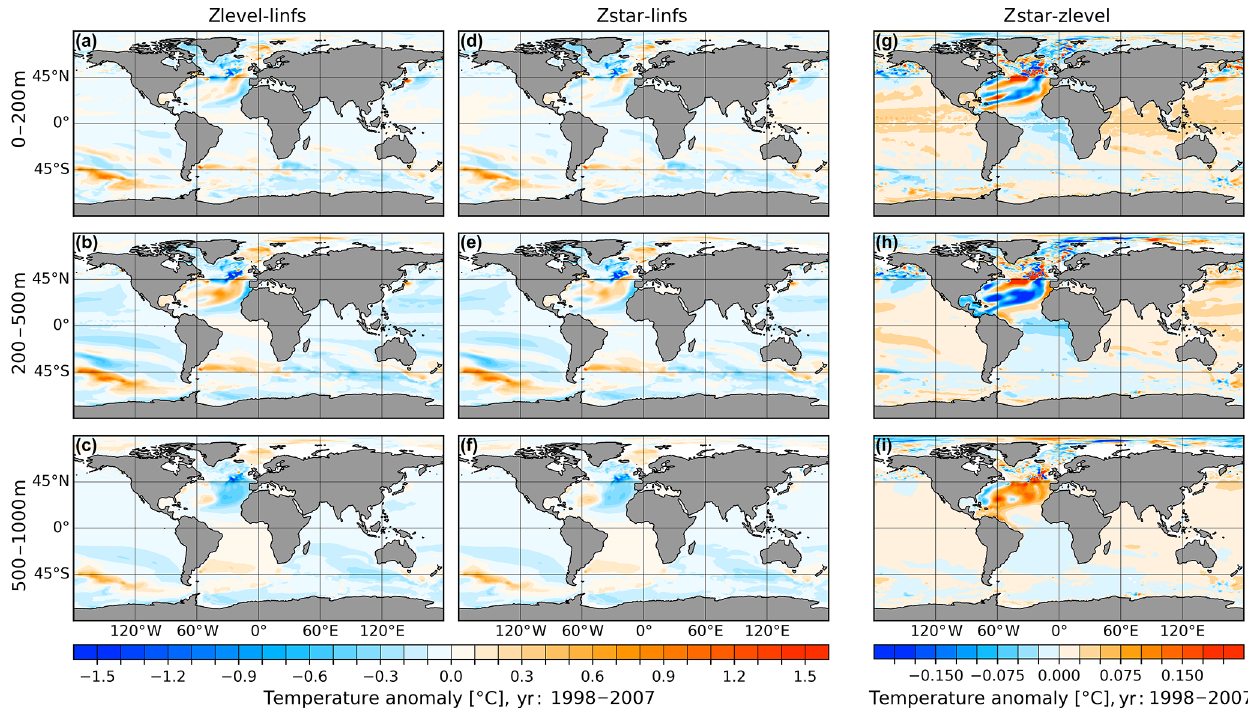
Figure 2. Temperature anomalies of the full free-surface simulations with respect to the linear free-surface simulation: zlevel minus linfs (a–c) and zstar minus linfs (d–f) . Panels (g–i) show the temperature difference between the two full free-surface simulations (zstar minus zlevel). From top to bottom, the three rows show the results for three different depth ranges: 0–200, 200–500 and 500–1000m. Averages over the time period of 1998–2007 are shown. Note that different color scales are used.